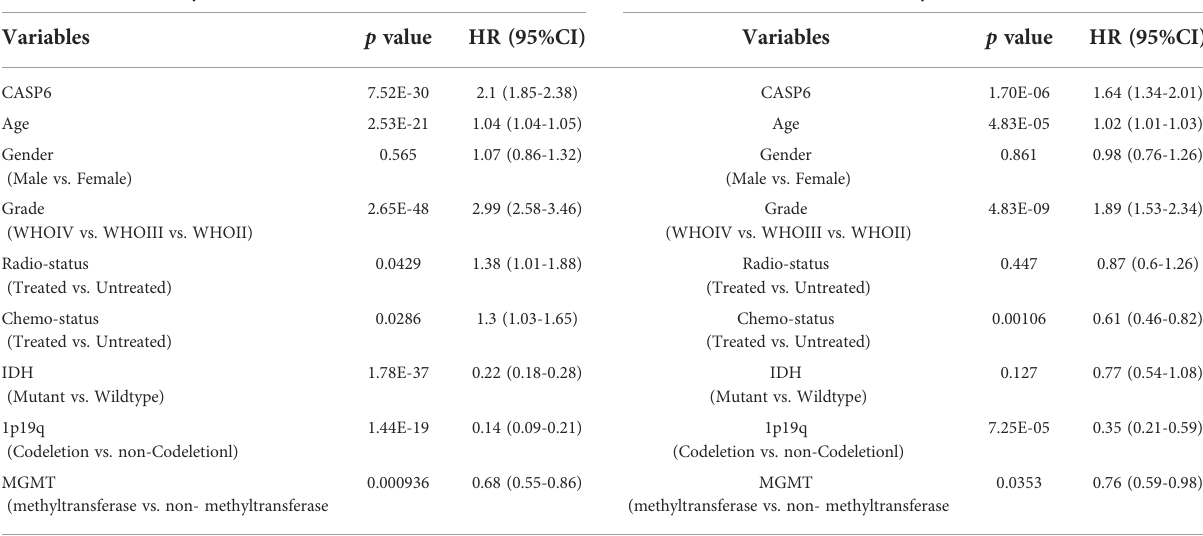
TABLE 2 Univariate and multivariate analysis of CASP6 and clinical features in the CGGA datasets. Univariate Cox analysis of CGGA